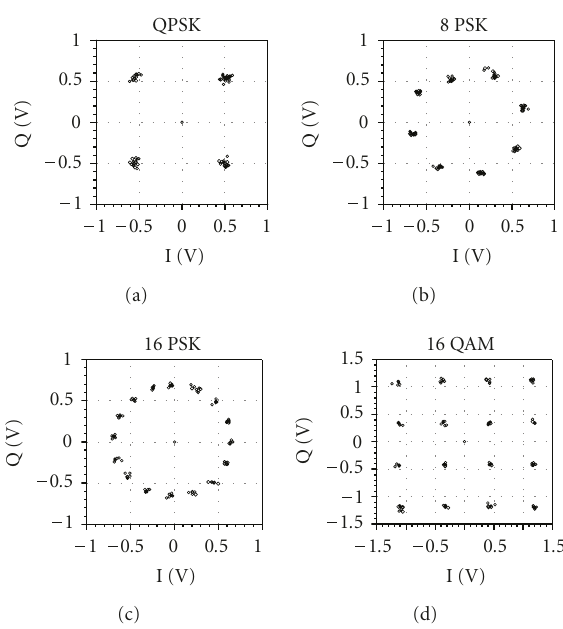
Figure 14: Demodulated high-speed MPSK/QAM signals.